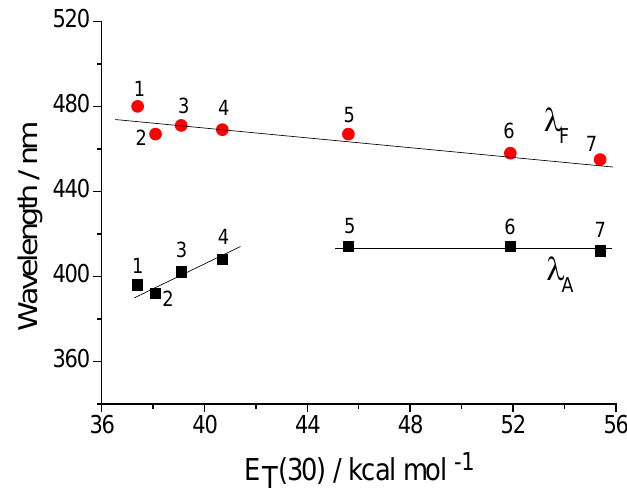
Figure 1. Solvent polarity dependence of absorption and fluorescence maxima: 1-tetrahydrofurane, 2-ethylacetate, 3-chloroform, 4-dichloromethane, 5-acetonitrile, 6-methanol, 7-ethanol.